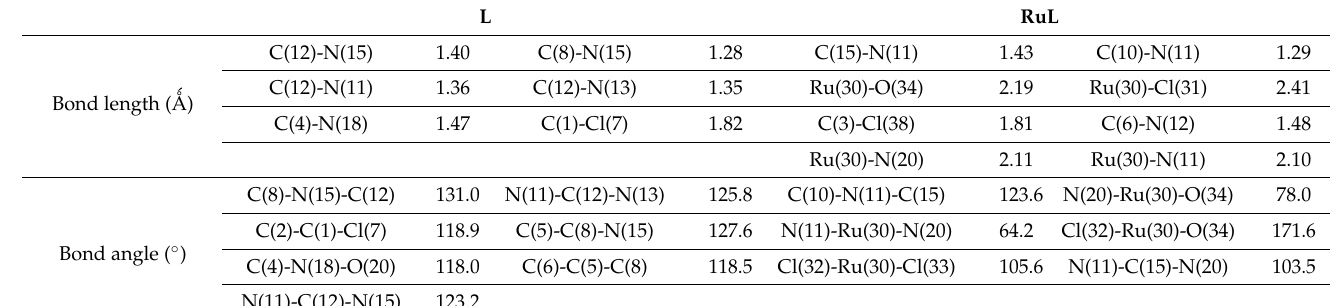
Table 1. Important bond lengths and bond angles for the ligand and its ruthenium complex. L